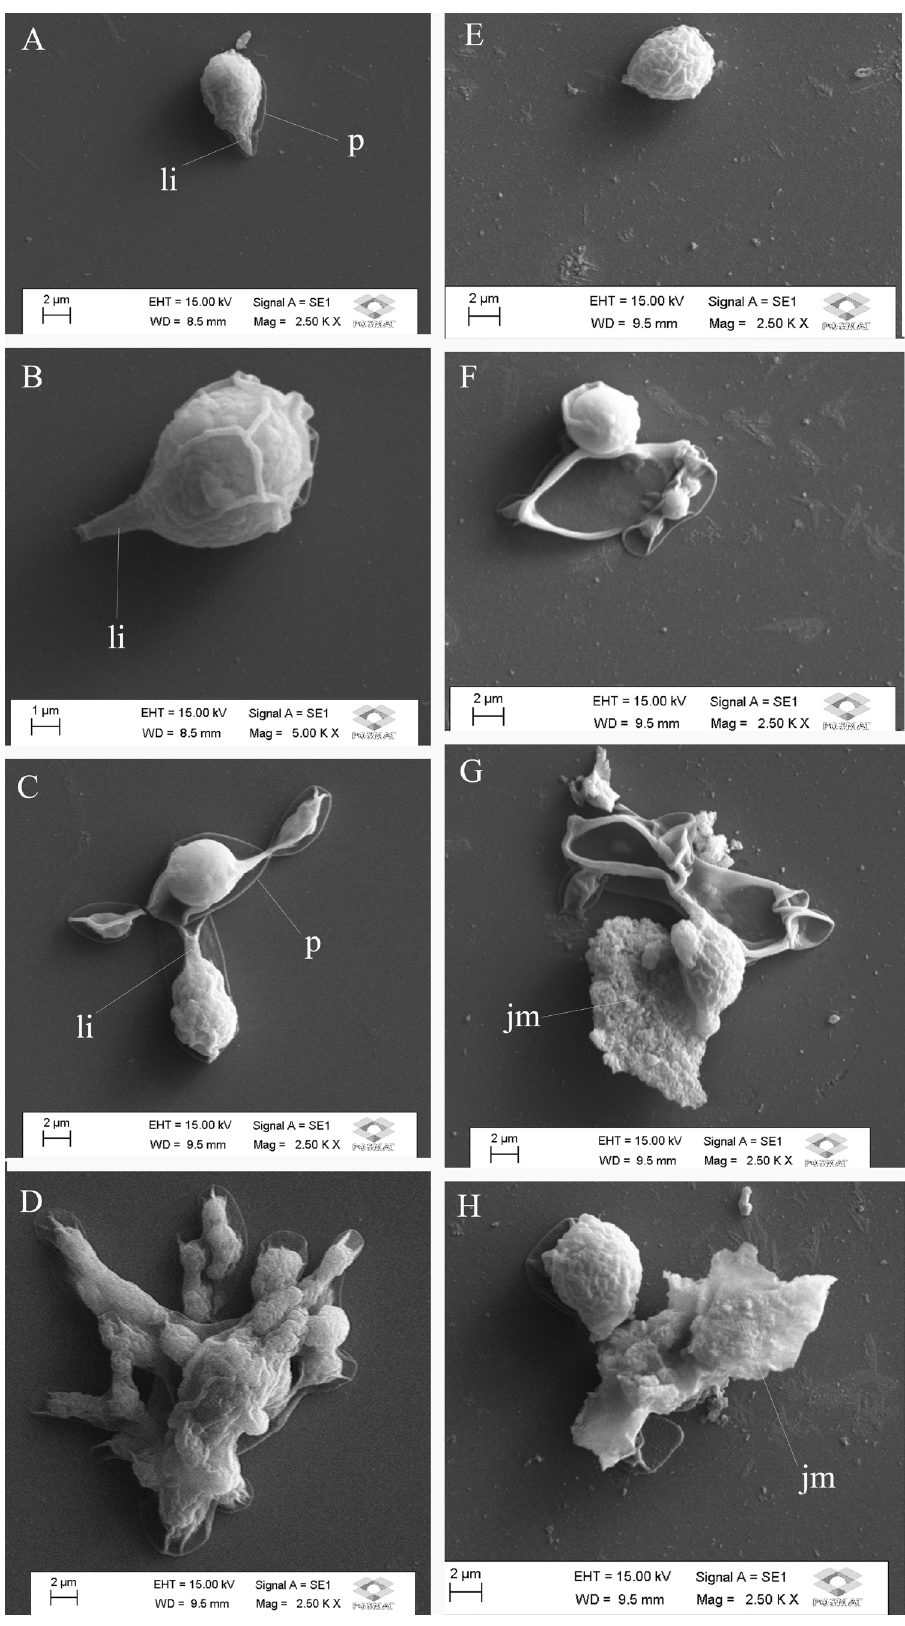
Figure 3. Scanning electron microscopy of yeast-phase cells of standard Paracoccidioides brasiliensis (PB18) strain. (A-D) Cells not treated with liriodenine. (E- H) Cells treated with liriodenine at the MIC of 31.2 μg.mL -1 . li: ligament; p: prolongation; jm: juxtaposed